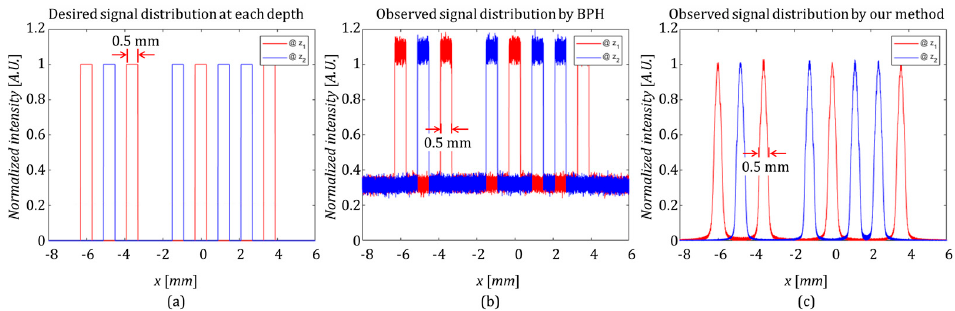
Figure 9. Simulation for holographic optical interconnections. ( a ) Desired signal distribution at each depth, simulation result for ( b ) the binary-phase hologram method and ( c ) the proposed method. (Red and blue line indicates the signal distribution at z 1 = 15 mm and z 2 = 30 mm,